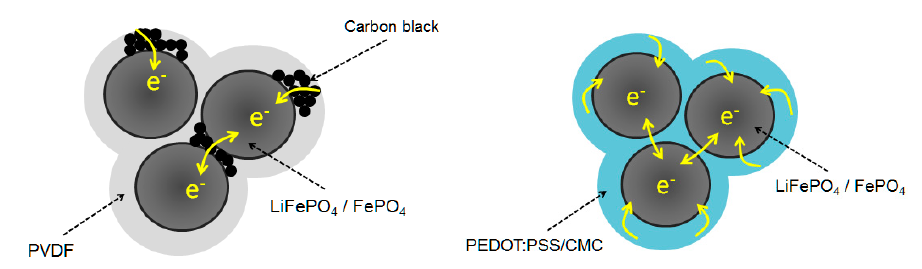
Figure 10. Electronic and ionic transport scheme for individual particles of active material in the media of PVDF and PEDOT:PSS/CMC [67].